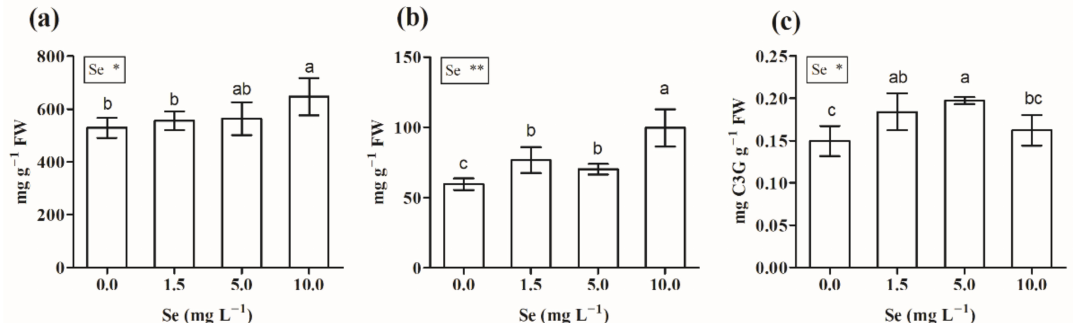
Figure 3. Total chlorophyll ( a ), carotenoid ( b ), and anthocyanin ( c ) contents in microgreens of P. oleracea grown indoors under controlled conditions with different concentrations of Se in the substrate. Bars indicated by the same letter are not statistically different for p = 0.05 after Duncan’s test. Significance level: ** p ≤ 0.01; * p ≤